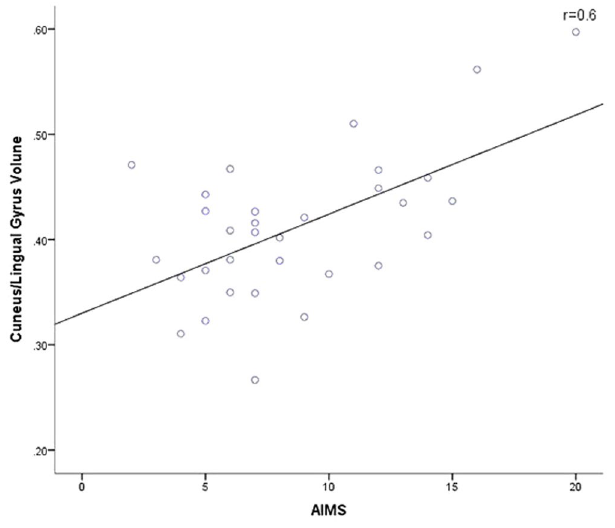
Figure 2. The relationship between Abnormal Involuntary Movement Scale score and gray matter changes in the cuneus or lingual gyrus in the schizophrenics with tardive dyskinesia group. The unit is cm 3